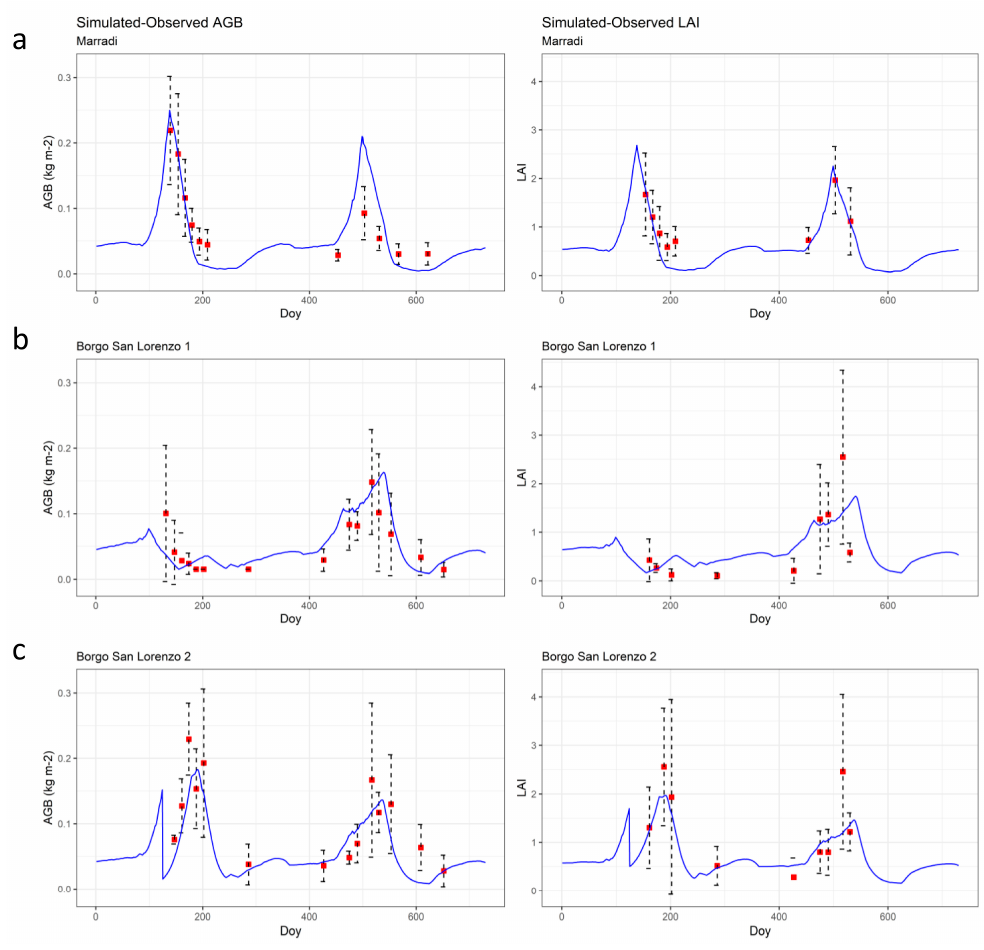
Figure 4 . Simulated (blue line) and observed (red square dots) patterns of aboveground biomass (AGB) and leaf area index (LAI) at Sites M ( a ), B1 ( b ), and B2 ( c ) for the period 2020–2021. Table 4. Model performance for the two study sites (M: Marradi; B: Borgo San Lorenzo, sub-areas B1 and B2) based on two performance metrics: R 2 , coefficient of determination of the linear regression between estimates and observations; and RRMSE (%), Relative Root Mean Square Error. AGB: aboveground biomass; LAI: Leaf Area